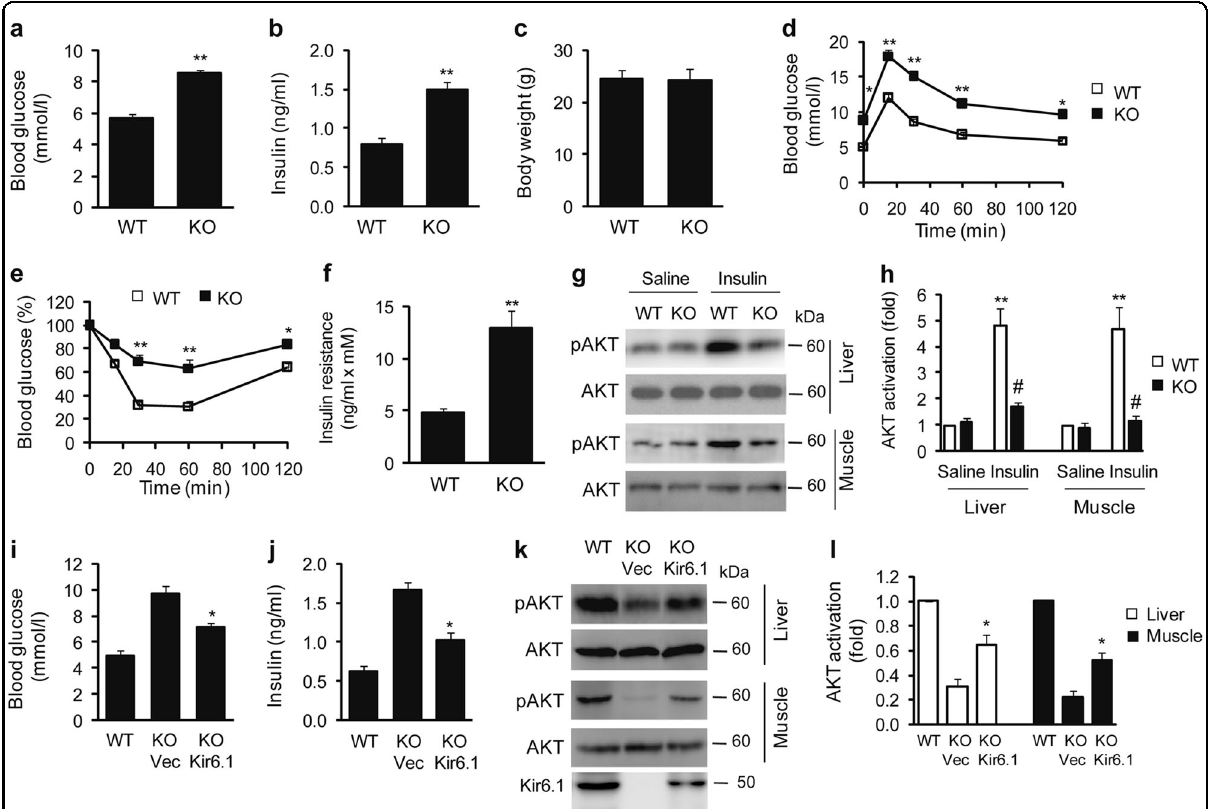
Fig. 4 Kir6.1 ablation leads to insulin resistance. a – c Basal blood glucose ( a ) and fasting serum insulin levels ( b ) and body weight ( c ) in WT and Kir6.1 KO mice after 4 h of fasting ( n = 12). d Oral glucose tolerance tests. Mice were fasted for 4 h prior to intraperitoneal injection of D-glucose (1.8g/kg body weight) ( n = 10). e Insulin tolerance tests. Mice were fasted for 4 h prior to intraperitoneal injection of insulin (0.75 U/kg body weight) ( n = 10). f HOMA-IR index of insulin sensitivity (HOMA = insulin [ng/ml] × glucose [mM]) ( n = 12). The data are presented as the mean ± SEM. * p < 0.05 and ** p < 0.01 vs WT. g Representative immunoblots showing inhibition of insulin-induced AKT activation by Kir6.1 knockout in the liver and skeletal muscle. The mice were injected with either saline or insulin (0.75 mU/g body weight) for 10 min. h Quanti fi cation of data shown in ( g ); n = 4. The data are presented as the mean ± SEM. ** p < 0.01 vs. the corresponding saline group; # p < 0.05 vs. WT mice injected with insulin. i , j Lentiviral expression of Kir6.1 reduced blood glucose ( i ) and insulin levels ( j ) in Kir6.1 KO mice; n = 6. k Kir6.1 expression enhanced AKT activation in the liver and muscle of Kir6.1 KO mice. l Quanti fi cation of data shown in ( k ); n = 4. The data are presented as the mean ± SEM. * p < 0.05 vs Kir6.1 KO mice injected with